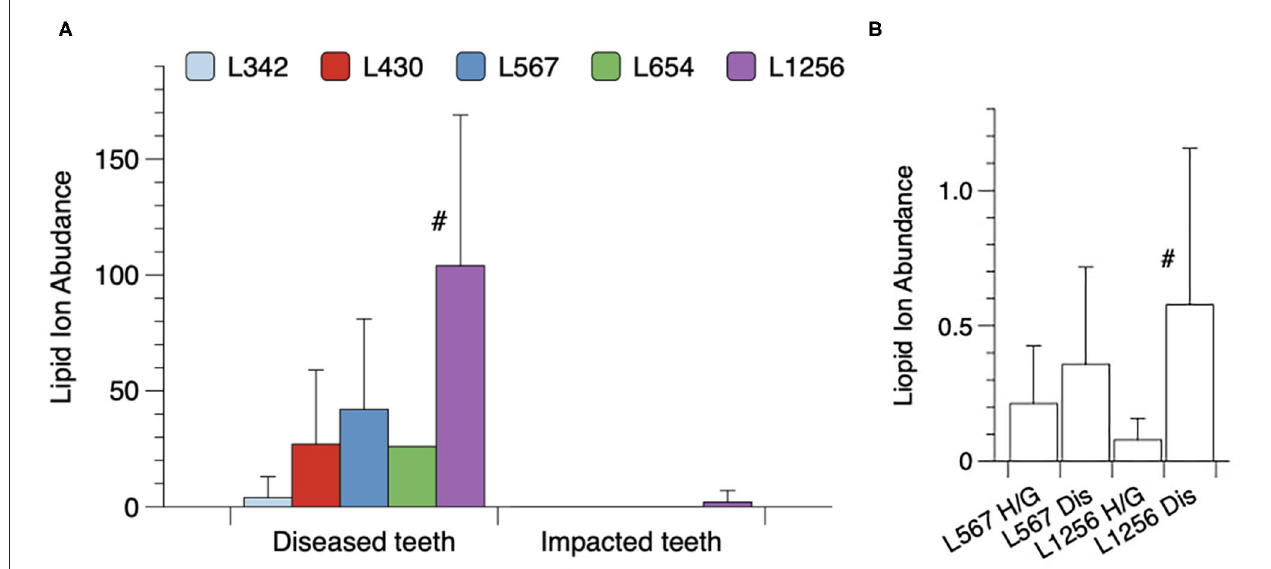
FIGURE 4 | Recovery of serine/glycine lipids on extracted teeth or recovered in surgical samples of gingival tissues. (A) Categories of teeth included either fully impacted third molars or hopeless teeth extracted due to stage III or IV periodontitis . The periodontitis-afflicted teeth were laden with gross amounts of dark subgingival calculus. Lipid extracts from individual teeth were dissolved in 120 ul of methanol and the samples were analyzed by LC-MS as described. Results are depicted as relative serine/glycine lipid ion abundances for five individual diseased (Dis) teeth and five individual impacted third molars (Imp) with a significant difference noted only for Lipid 1256 (#, by Tukey’s multiple comparisons test ). (B) Excised gingival tissue samples were collected and analyzed as described in section Materials and Methods. Equivalent amounts of total lipid extract from each gingival tissue sample were analyzed by LC-MS. Histogram bars represent the mean ion abundances of each lipid class with standard deviations indicated by vertical error bars. A total of 7 healthy/gingivitis and 10 severe periodonitis samples were analyzed. The number of samples positive for Lipid 1256 was 8 out of 10 for diseased (Dis) samples and 2 out of 7 for the healthy/gingivitis (H/G) samples. The mean level of Lipid 1256 was significantly elevated in diseased samples compared with healthy/gingivitis samples (#, Tukey’s multiple comparisons test ). Serine/glycine lipid classes other than Lipid 1256 and Lipid 567 were not detected in lipid extracts from diseased gingival tissue samples.